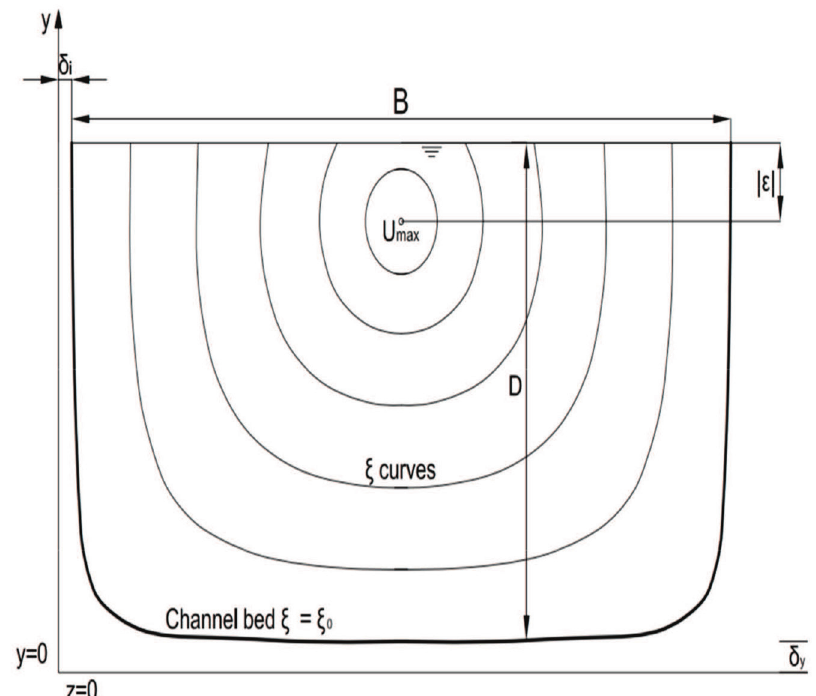
Figure 1. Curvilinear coordinate system based on Chiu and Chiou